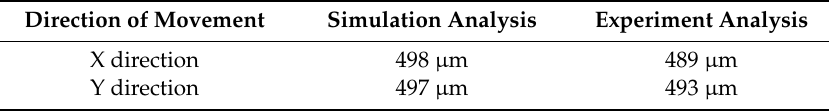
Table 5. Platform output displacement comparison table.